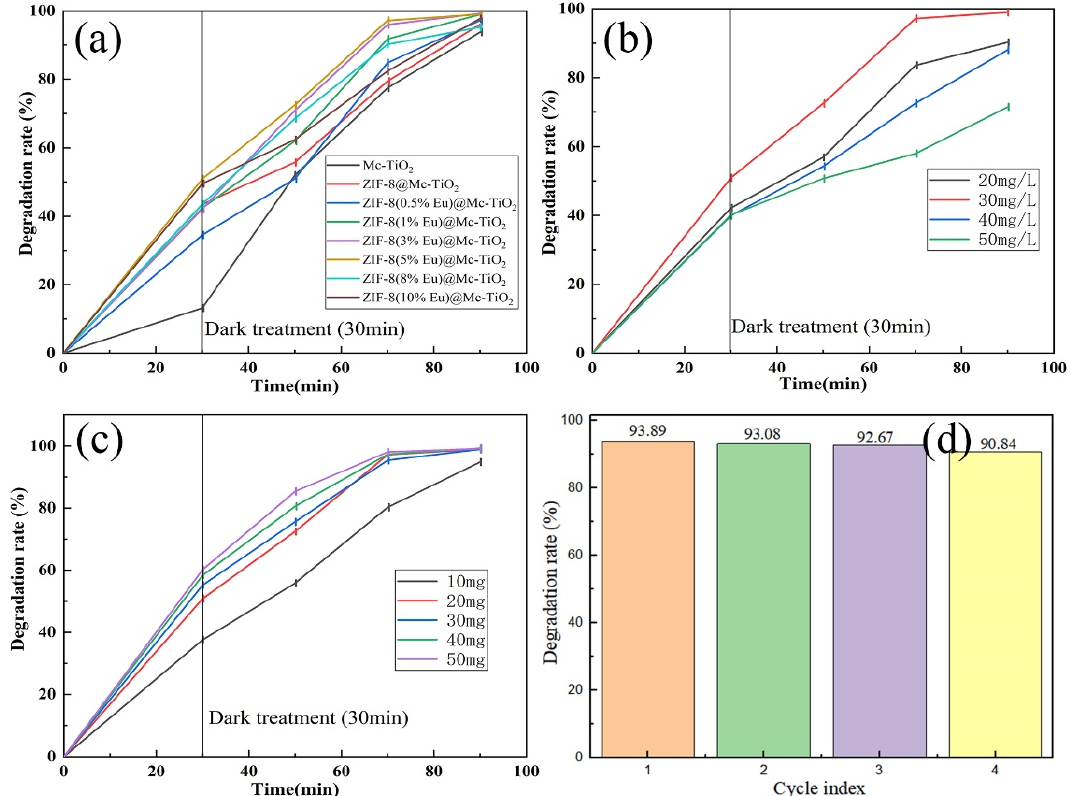
Figure 7. ( a ) ZIF-8(Eu)@Mc-TiO 2 and Mc-TiO 2 photo catalytic efficiency diagram, ( b ) effect of initial concentration of basic fuchsin on catalytic efficiency, ( c ) effect of catalyst dosage on catalytic efficiency and ( d ) recycling times of catalyst.